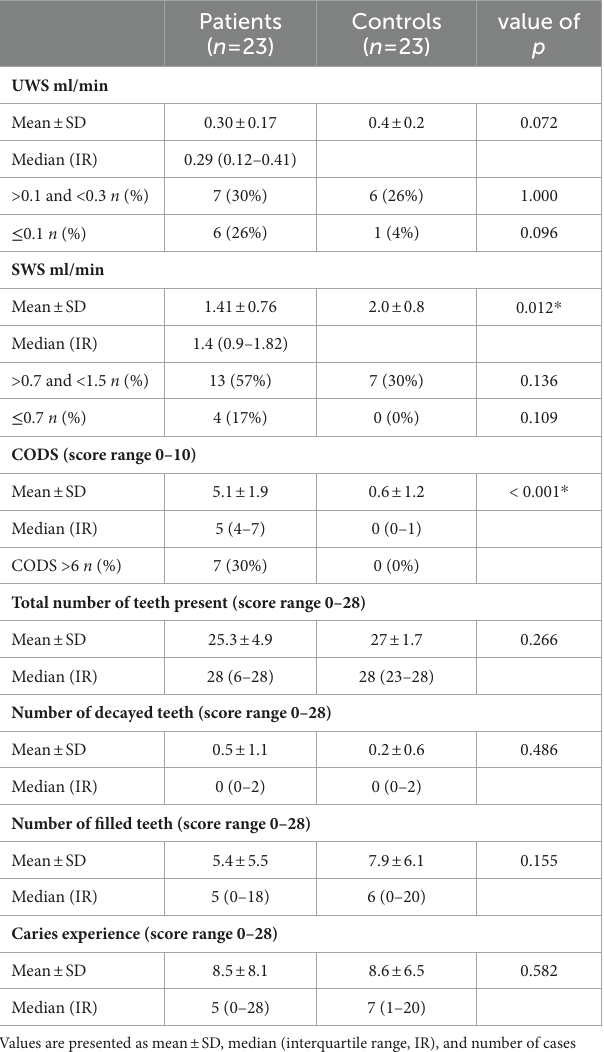
TABLE 4 Results from unstimulated whole saliva (UWS) secretion, stimulated whole saliva (SWS) secretion, CODS (Clinical Oral Dryness Score), and dental status.